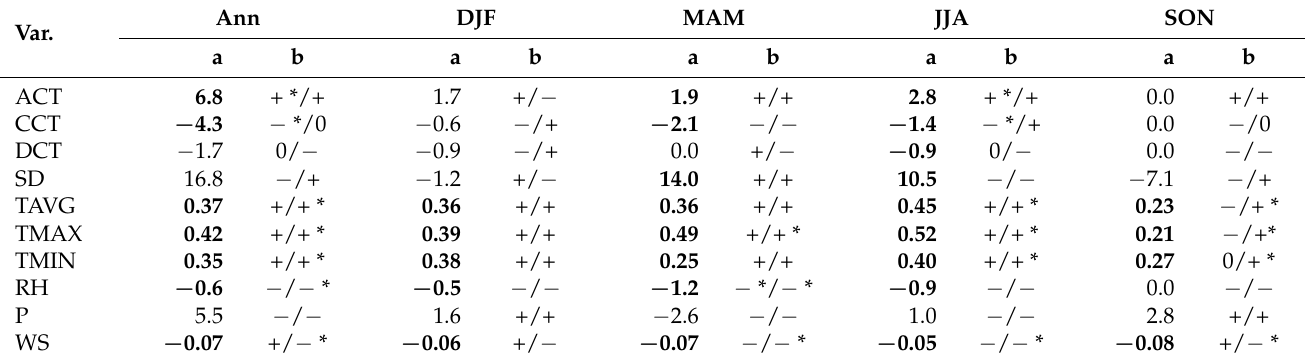
Table 10. Linear trends of selected annual (Ann) and seasonal (DJF, MAM, JJA, and SON) series of circulation types and climatic variables (Var.) in 1961–2020 (a) in comparison with signs of linear trends (+ positive, − negative, 0 no trend) in two 30-year normal periods, 1961–1990 and 1991–2020 (b): ACT—anticyclonic circulation types (days/10 years), CCT—cyclonic circulation types (days/10